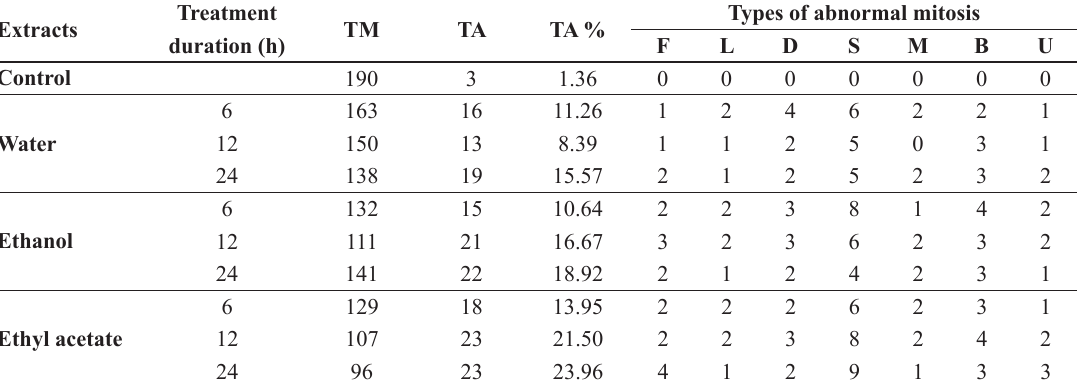
Abnormal mitosis and types of mitotic abnormalities in Vicia faba (Giza 3) after root treatments f with different extracts of Dipterygium glaucum